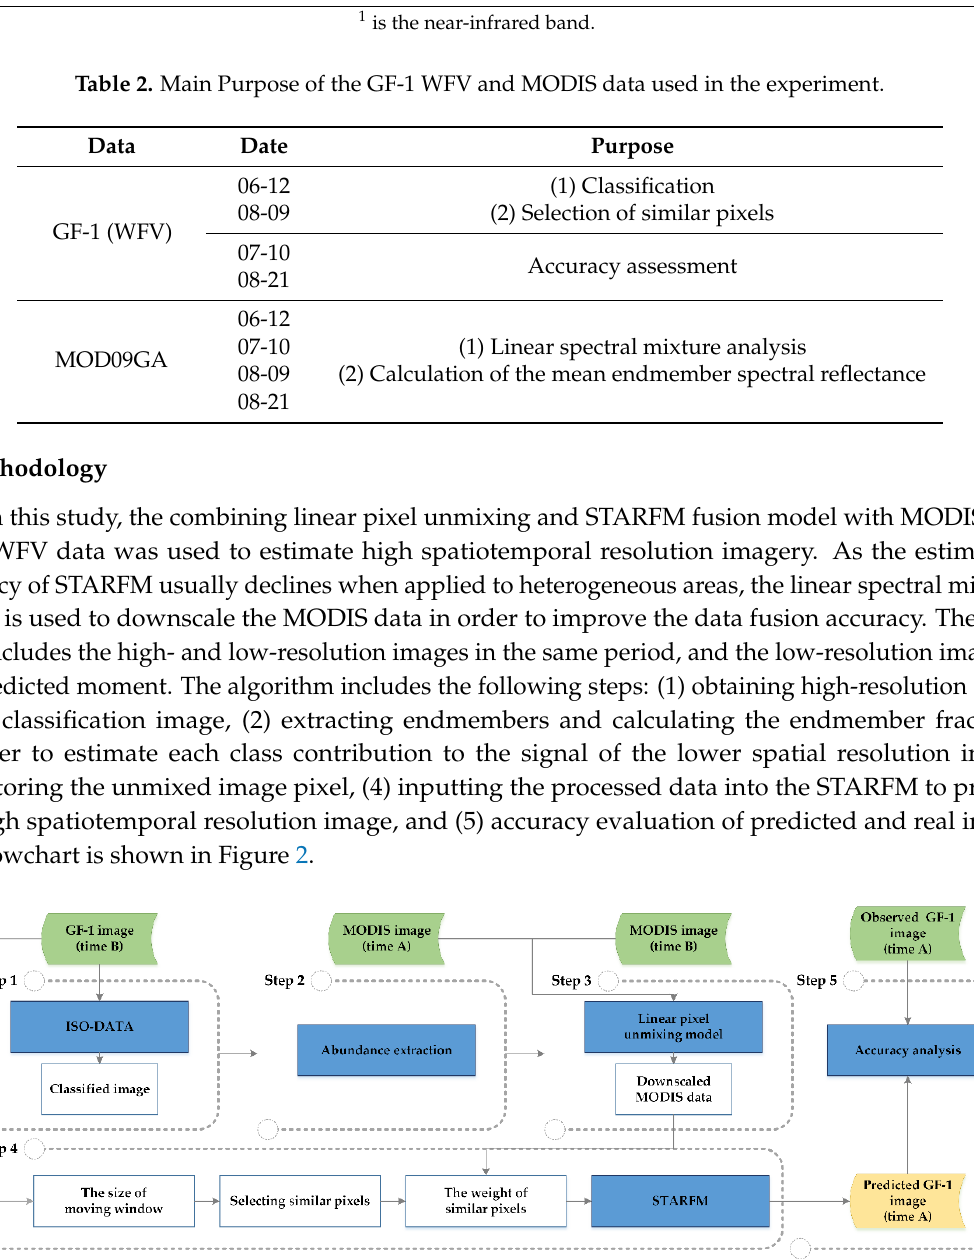
Figure 2. Flow chart of combining linear pixel unmixing and STARFM for high spatiotemporal fusion imagery.